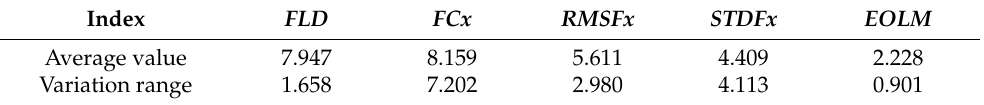
Table 9. Useful features of the yaw